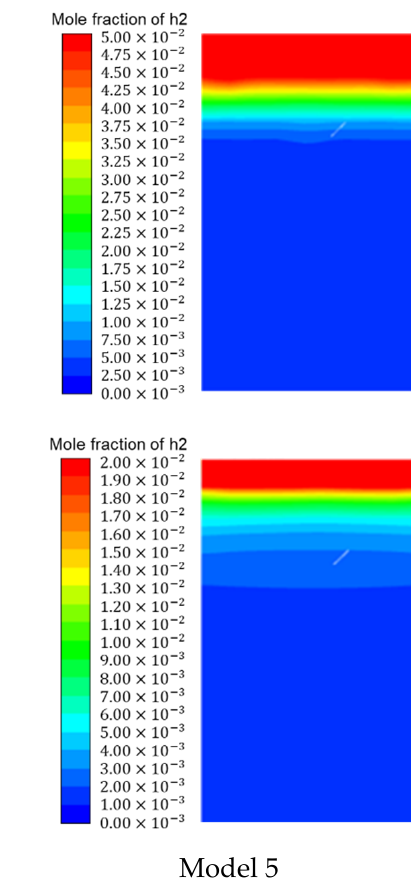
Figure 10. Contours of mole concentration of hydrogen for Model 1–Model 5 after the envelope of 4% mole fraction (up) and 1% mole fraction (down) of hydrogen filling the whole ceiling.